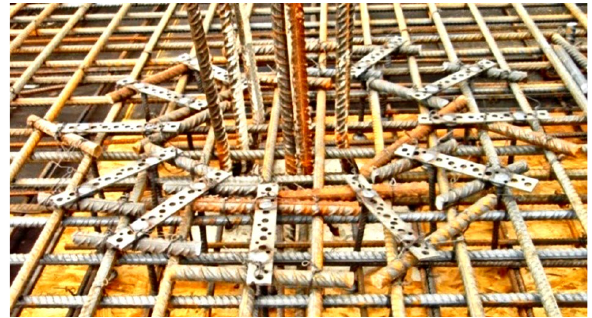
Figure 1. An example of moving down the top reinforcement by about 20 mm within the support zone of the flat